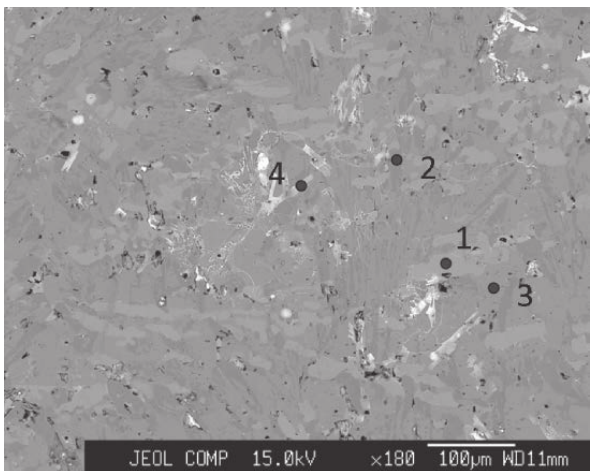
Fig. 6: Backscattered electron micrograph of CMS-HC slag, near the bottom of the crucible. Points: 1 = merwinite, 2 = monticellite, 3 = melilite, 4 = melilite (containing chlorine).